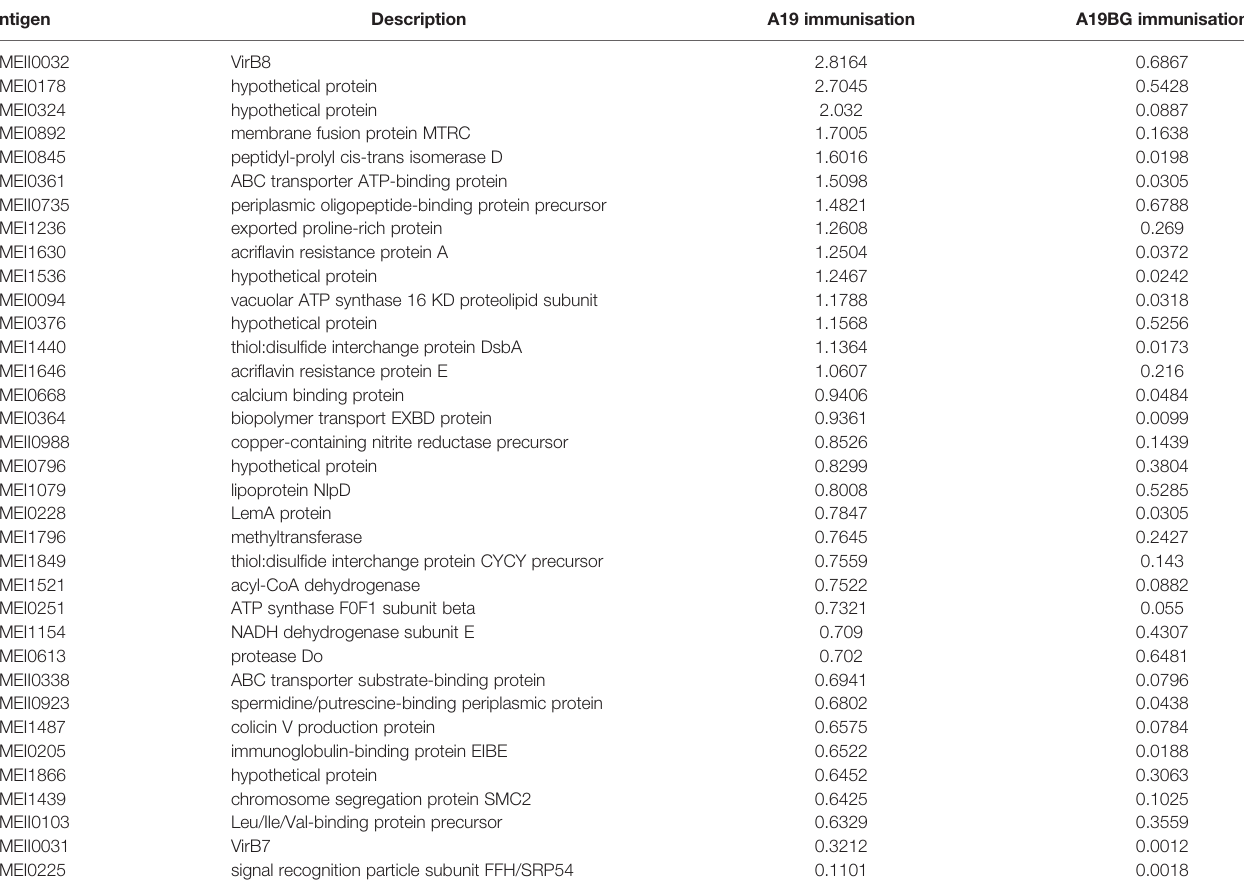
TABLE 3 | Differential IgG levels induced by different antigens 28 days after immunisation with A19 and A19BG.